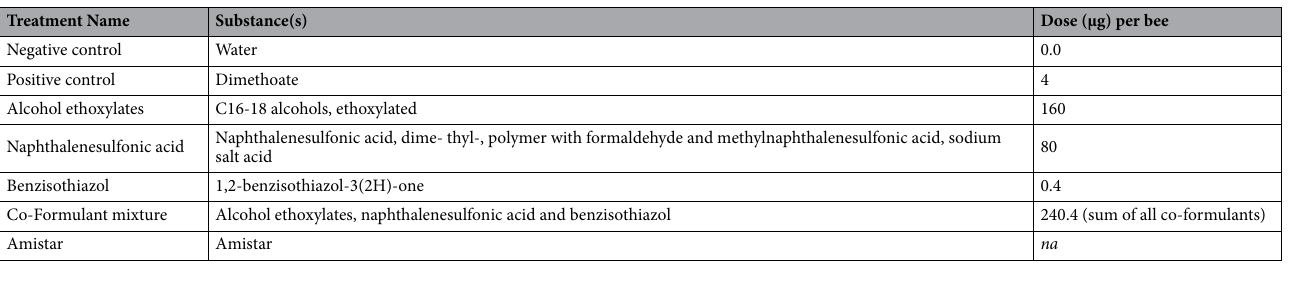
Table 1. Doses of chemicals used in each treatment